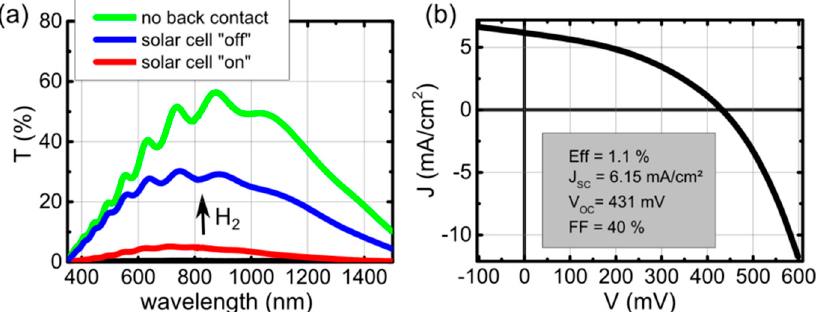
Figure 7. Realization of switchable solar cell: transmission measurements of cells in a cavity “on” and cavity “off” state ( a ). As a reference, a cell w/o back contact is shown. The JV -curve of the cell in cavity “on” state ( b ).